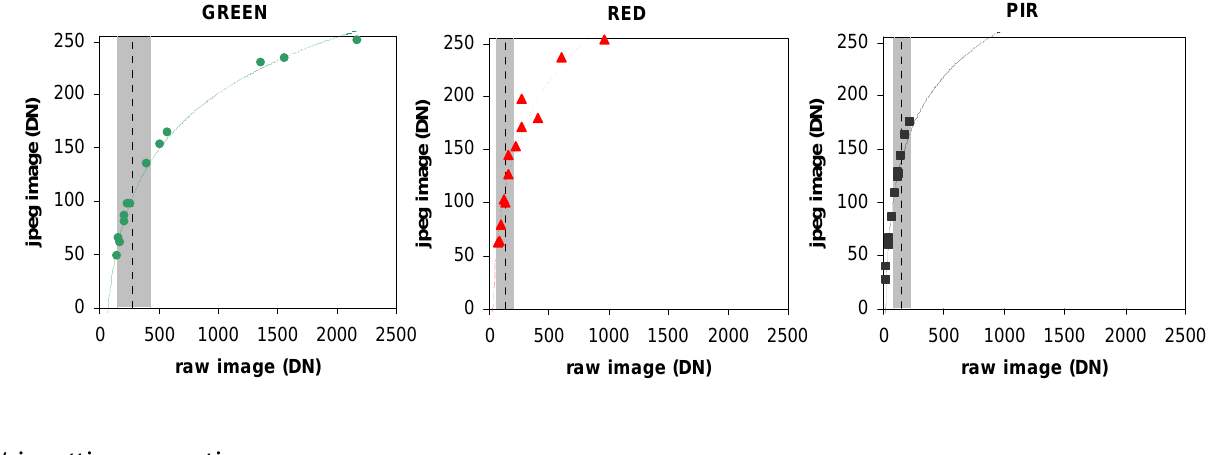
Figure 7. Comparison of the digital numbers (DN) of an image in unprocessed (RAW) and JPEG formats. Logarithmic curves are drawn for each band. Dotted lines represent the mean raw DN measured on vegetation. Grey zones represent mean  2 standard-deviations.